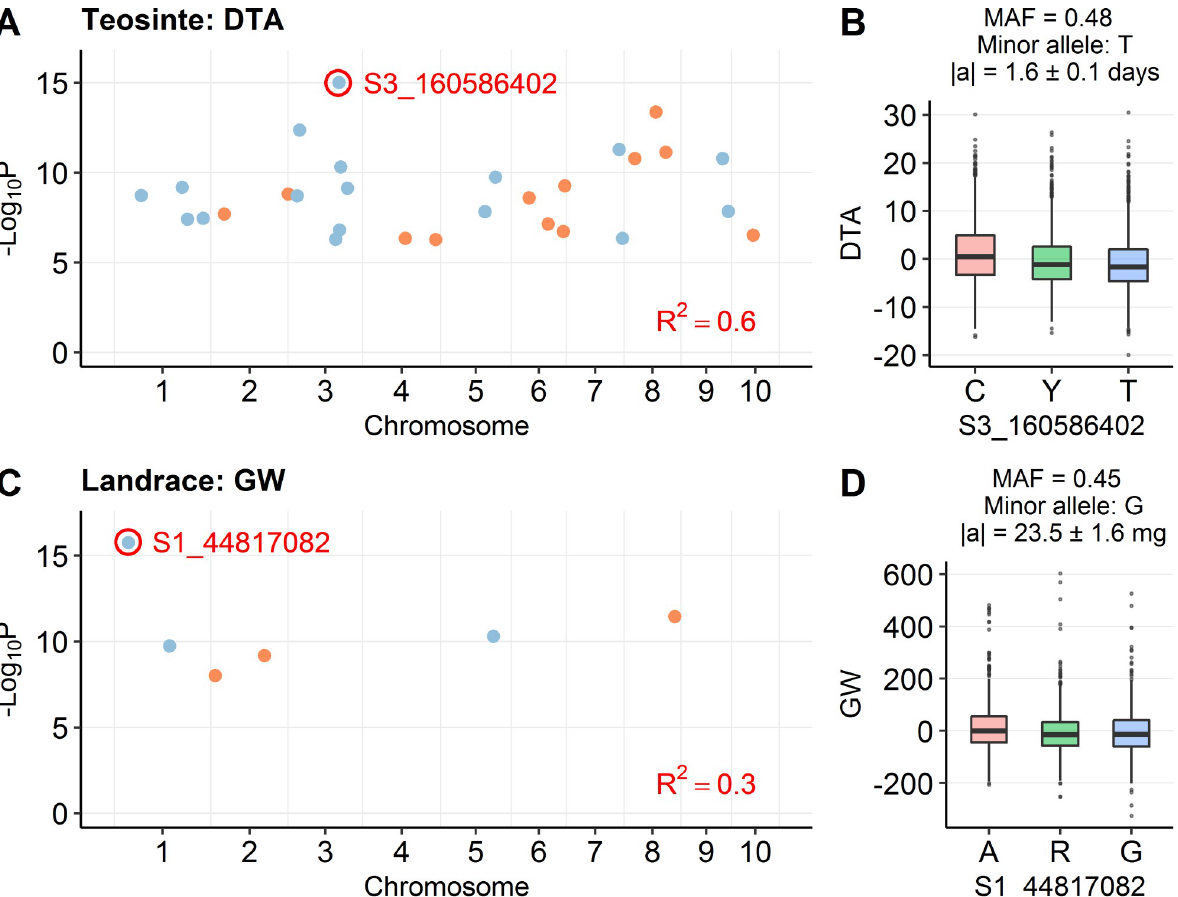
Fig 4. Examples of QTL under balancing selection. (A) The distribution of detected QTL for DTA in teosinte. The most significant QTL is labeled as S3_160586402. (B) The phenotypic effect of QTL S3_160586402. (C) The distribution of detected QTL for GW in maize landrace. The most significant QTL is labeled as S1_44817082. (D) The phenotypic effect of QTL S1_44817082. In (A) and (C), QTL in different chromosomes are shown in different colors; R 2 stands for r-square explained by overall QTL model. In (B) and (D), the phenotype is shown in residuals after accounting for covariates; |a| stands for absolute additive effect (mean ±